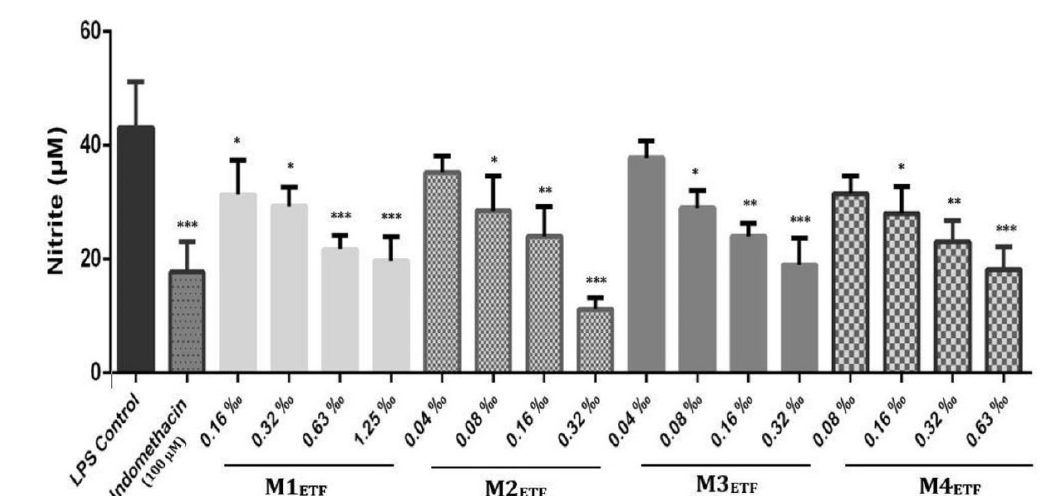
FIGURE 3 - The amount of nitrite in LPS-induced RAW 264.7 macrophages. Values are expressed as the mean ± SD of various experiments. *p < 0.05. **p < 0.01 and ***p < 0.001 indicate a significant difference from the LPS-stimulated control